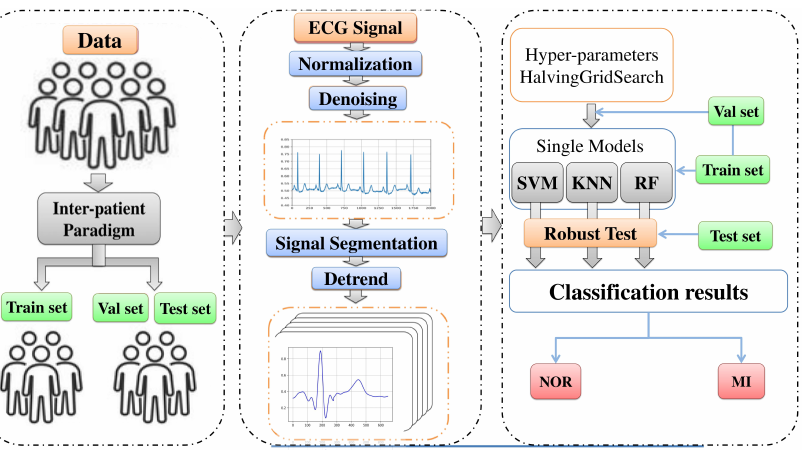
Figure 1. Overall procedures in ECG myocardial infarction classification based on the proposed